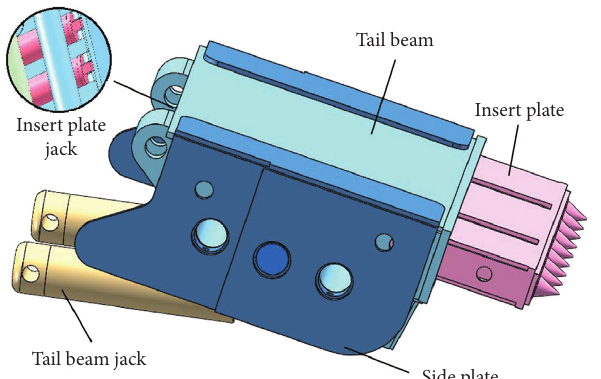
Figure 4: The coal-drawing